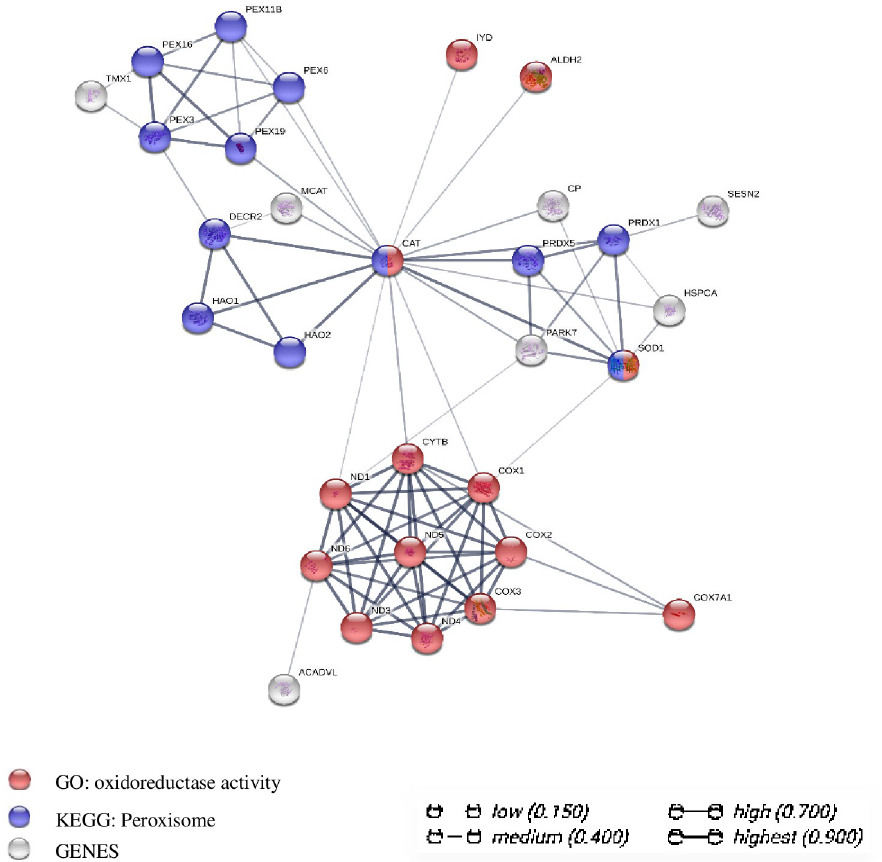
Fig 5. Analysis diagram of gene co-expression network interaction of DEGs between WAE group and control group. Each node represents all the proteins produced by a coding gene; the correlation of proteins is specific and meaningful, for example, proteins contribute to a common